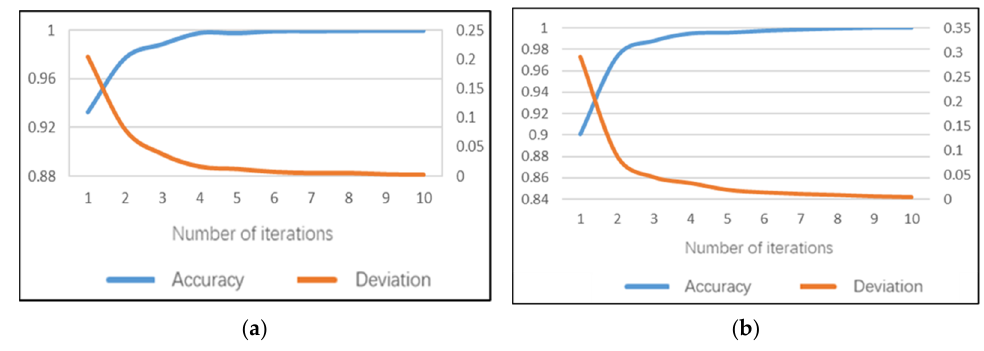
Figure 14. Training performance of behavior posture set sub-model: ( a ) daytime; ( b ) night.